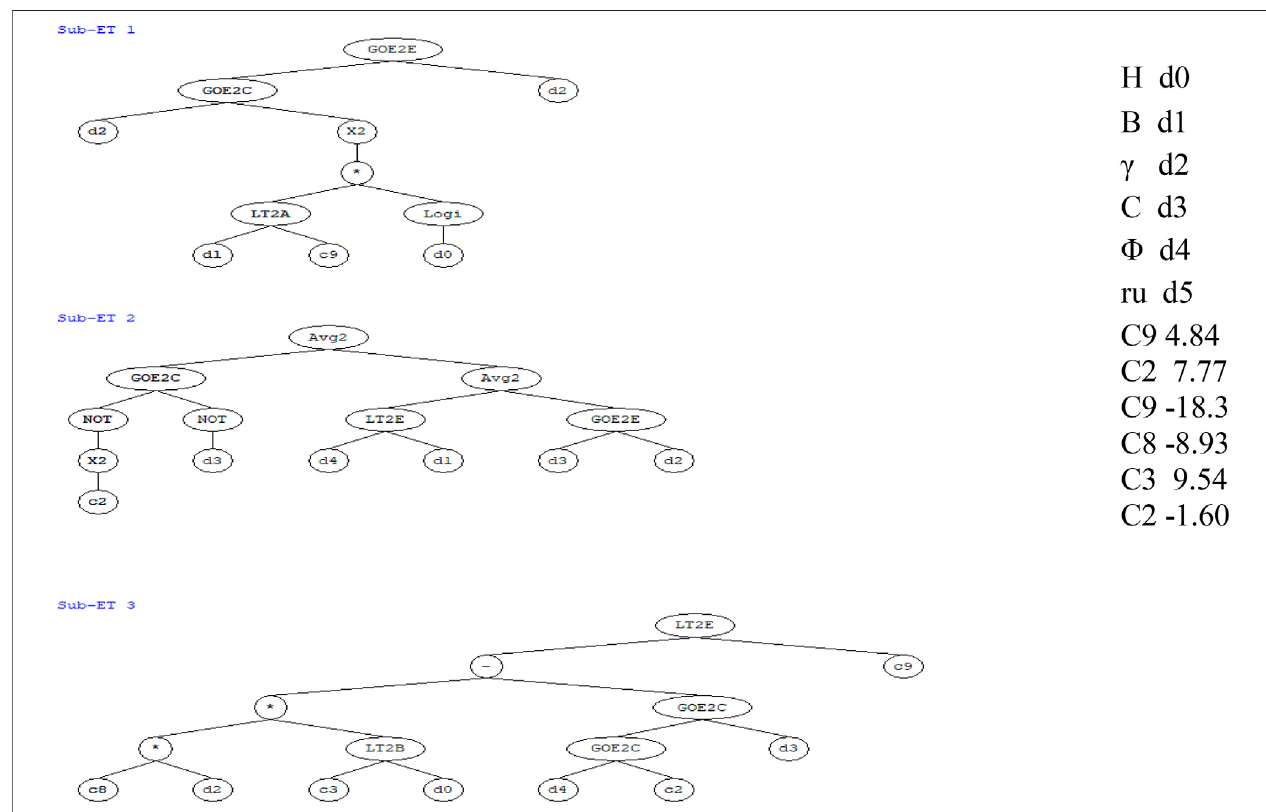
FIGURE 3 | Tree Expression to classi fi ed slope stability.